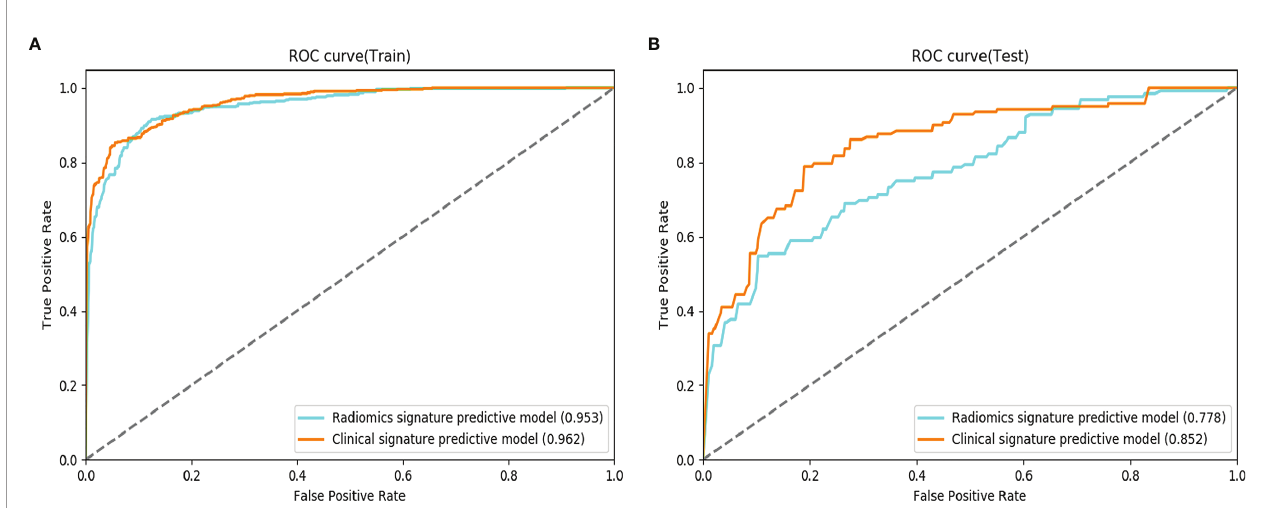
FIGURE 4 | Comparison of receiver operating characteristic (ROC) curves for the prediction of microvascular invasion. ROC curves of the radiomics signature predictive model and the clinical signature predictive model, which combines the fusion radiomics signature and clinicoradiological factors in the training (A) and testing (B)